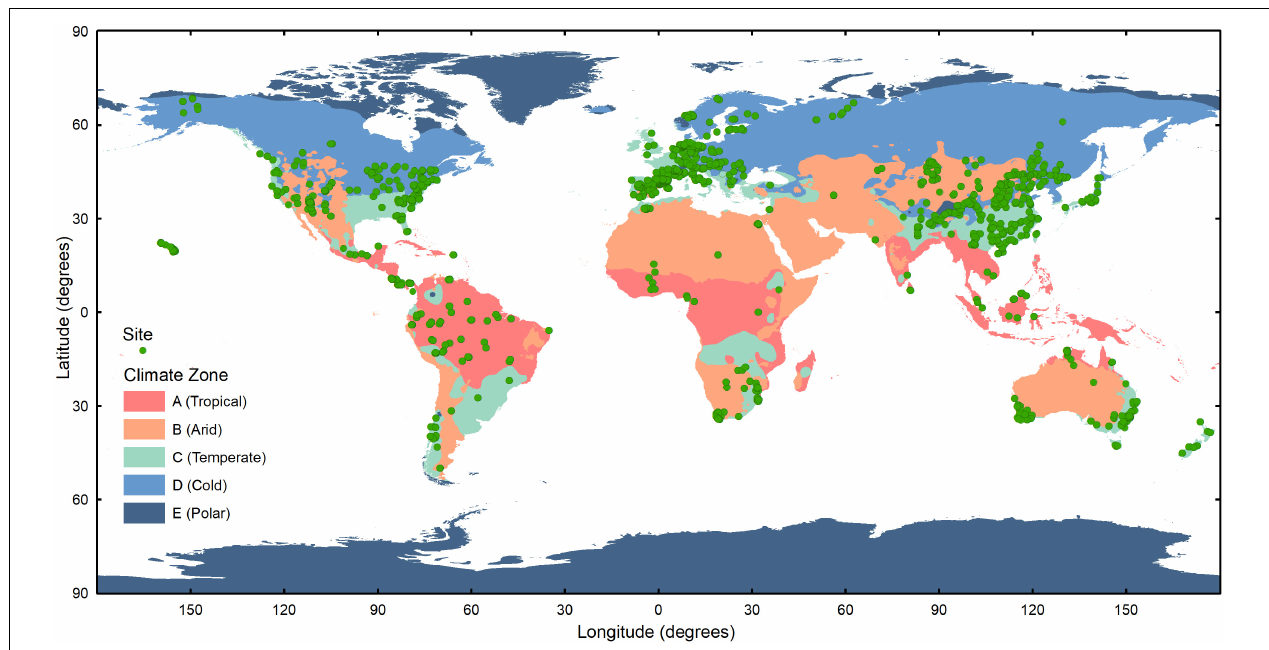
FIGURE 2 | Distribution of the sites to which the leaf traits belong in different climate zones of the world. The climate zones are divided into A (Tropical), B (Arid), C (Temperate), D (Cold), and E (Polar) zones with reference to the Köppen–Geiger system (Peel et al., 2007).